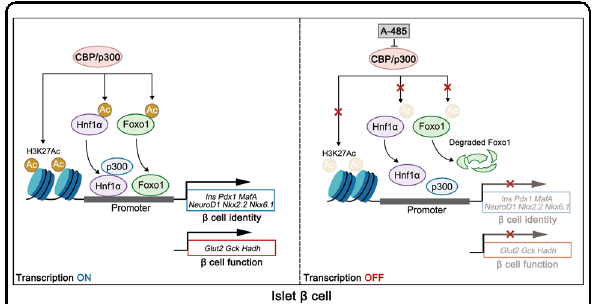
Fig. 7 The schematic illustration summarizes CBP/p300 HAT- governed transcription network in islet β cell. The HAT activity of CBP/p300 is required for maintaining the expressions of β cell identity genes and functional genes partially via acetylating histone H3K27 as well as transcription factors Hnf1a and Foxo1. Inhibition of CBP/p300 HAT by A-485 leads to the deacetylation of H3K27, which restricts chromatin accessibility. In addition, inactivation of CBP/p300 HAT also decreases the acetylation levels of Hnf1 α and Foxo1, repressing the transcription activation of the target genes by preventing the interaction of Hnf1 α and p300 as well as promoting Foxo1 protein